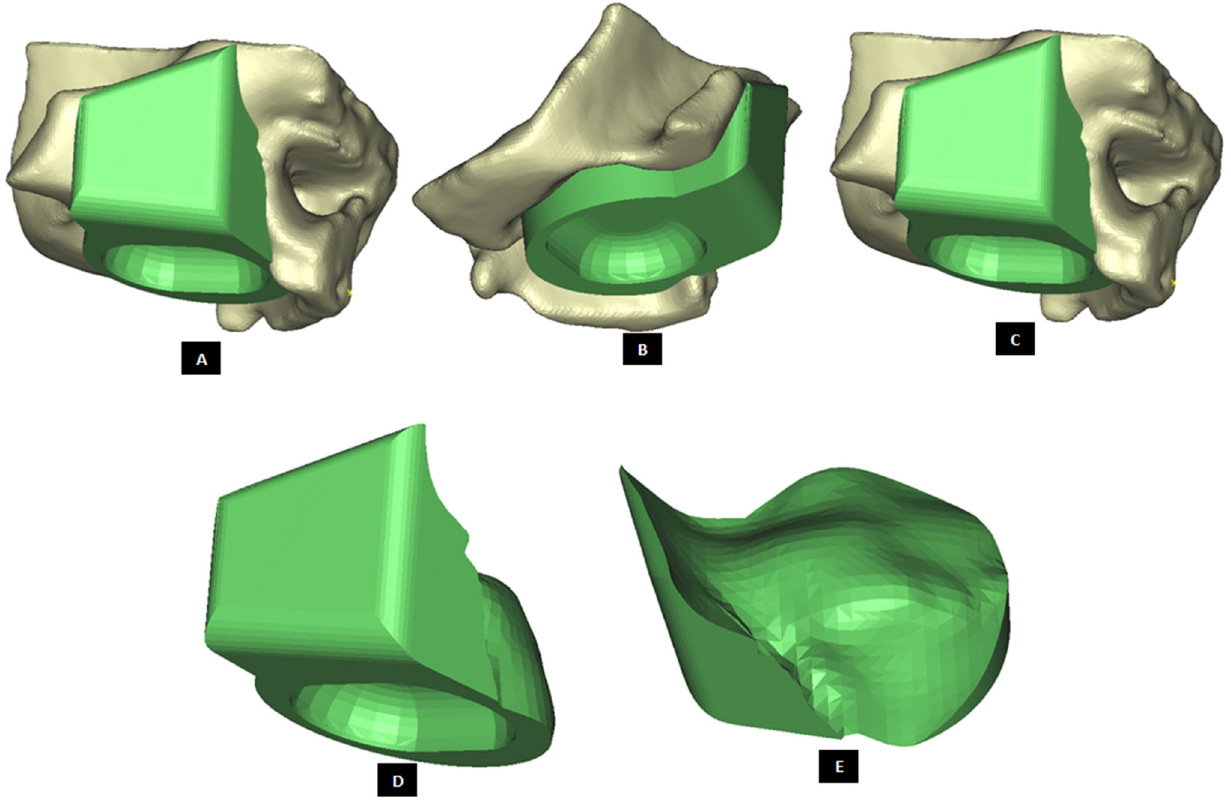
Figure 14. Patient-fitted design of a fossa prosthesis. ( A – C ) Illustrate accurate fit of the device to the patient’s natural fossa and eminence. The rectangular slot (with curved anterior and posterior edges) in inferior surface of the implant is designed to provide sufficient rotation and opportunity for anterior-posterior and medio–lateral translation of the matching prosthetic condylar head. The articular grove is designed such that it would prevent dislocation of the prosthetic condylar head during functional movements of the jaw. Visuals in ( D , E ) show that the superior surface of the implant is designed to accurately match the shape of natural fossa. Sufficient thickness is maintained for the lateral portion of implant to pre-drill screw holes which can host locking screws for better fixation and